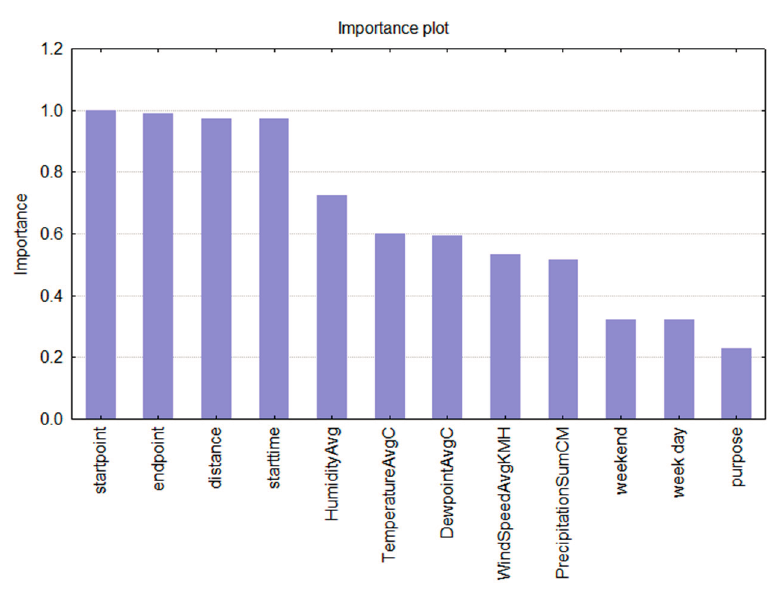
Figure 3. Predictor variables importance